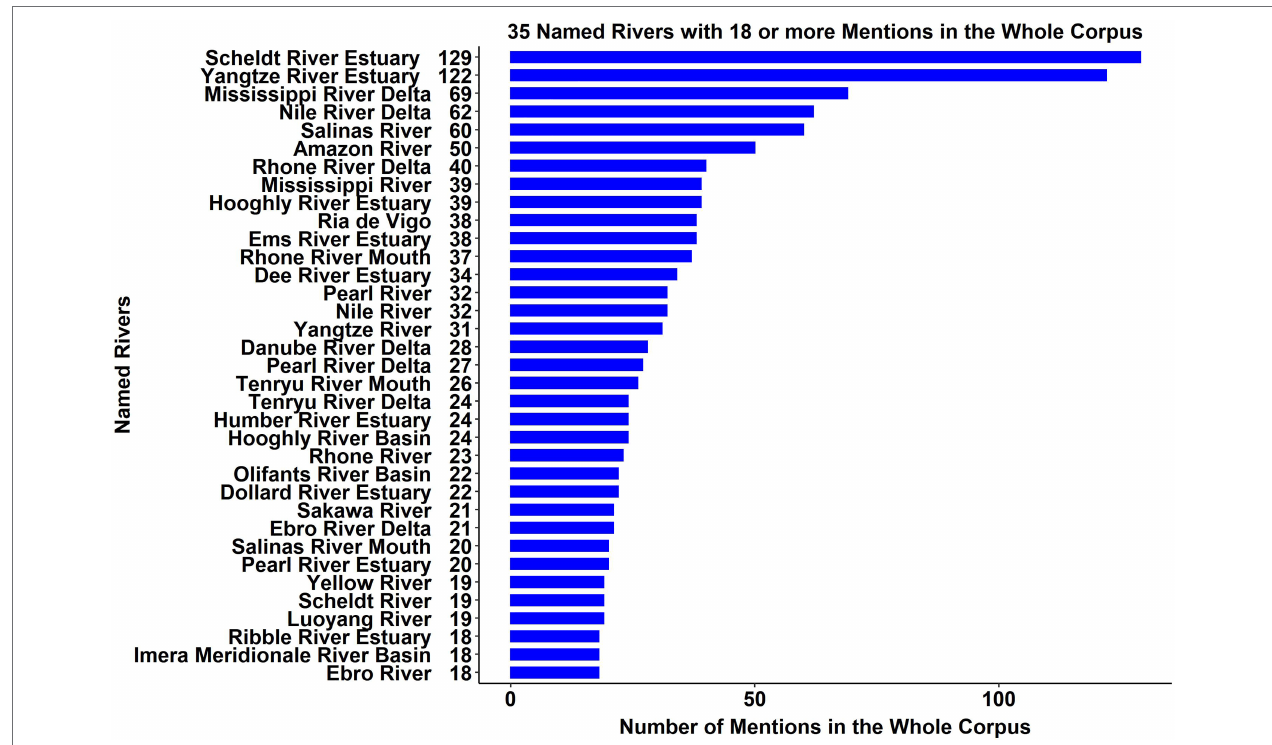
FIGURE 2 | A sample of 35 designations of rivers and their number of